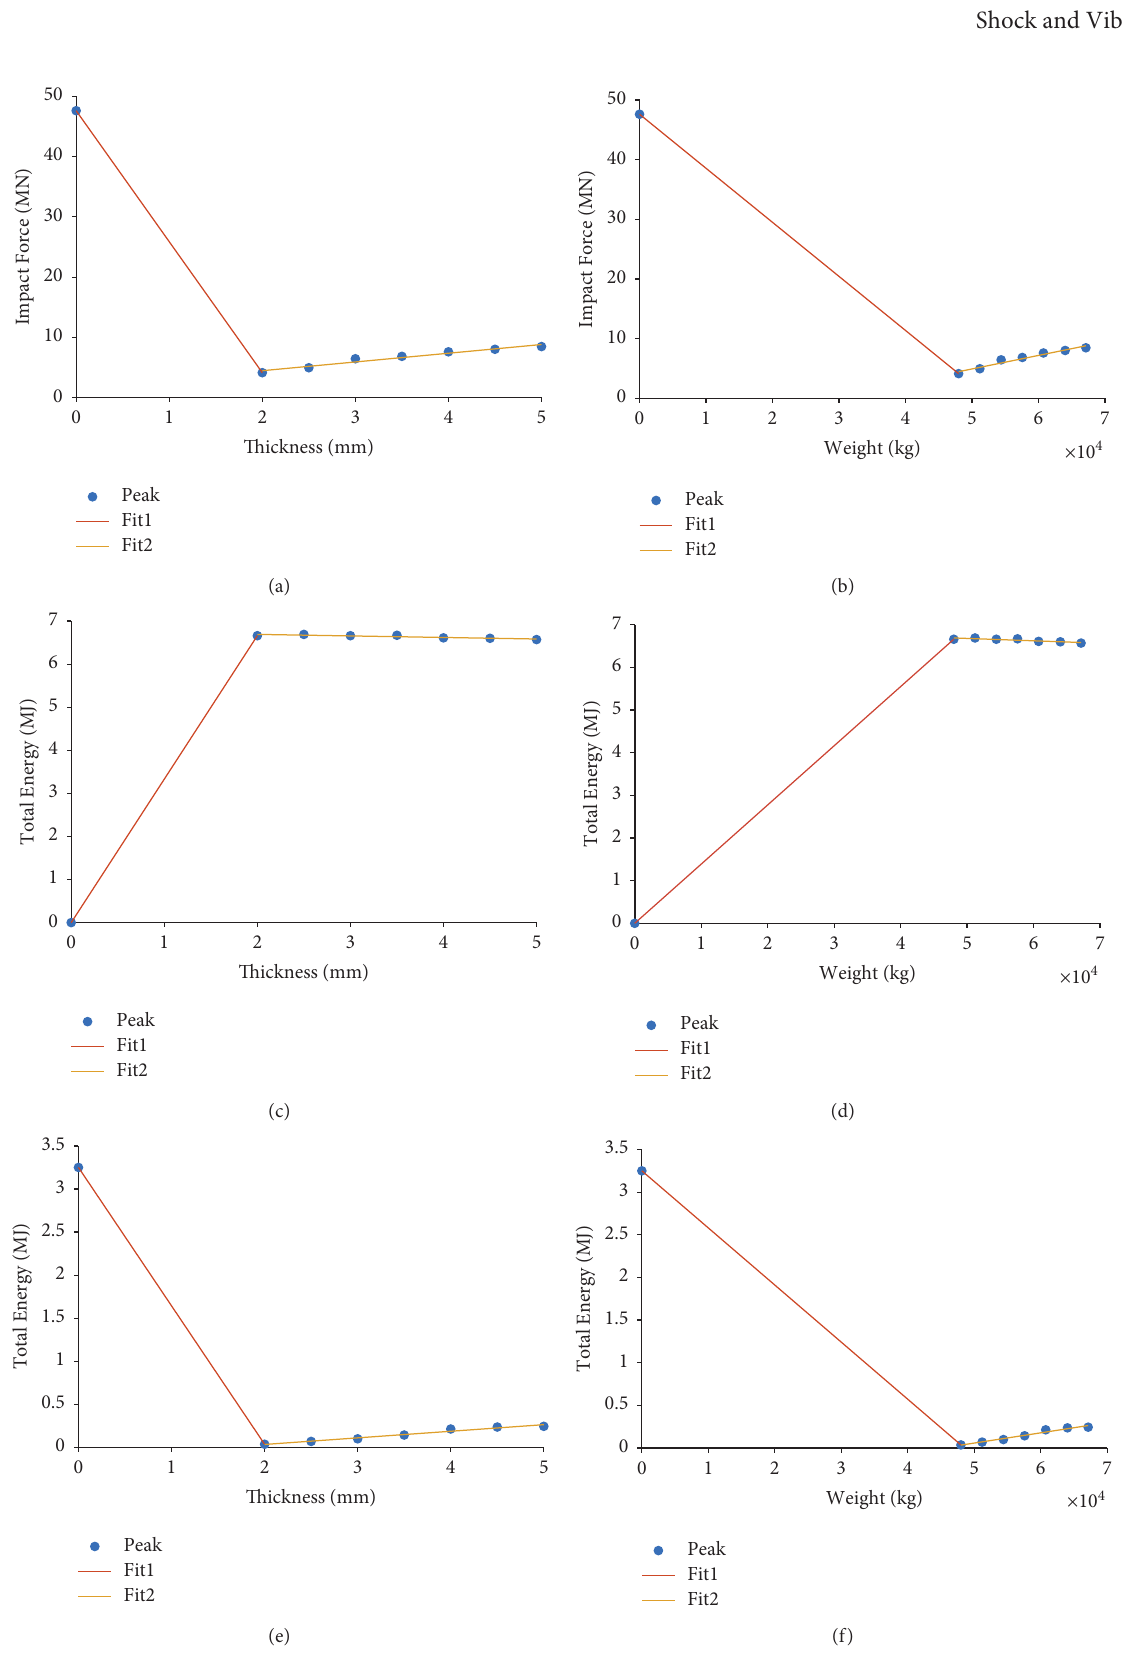
Figure 12: Relationship curve: (a, b) the relationship curves between the plate thickness or weight of the CSP and the peak value of bridge pier impact force, respectively; (c, d) the relationship curves between the plate thickness or weight of the CSP and the peak value of CSP total energy, respectively; (e, f) the relationship curves between the plate thickness or weight of the CSP and the peak value of the bridge pier total energy,